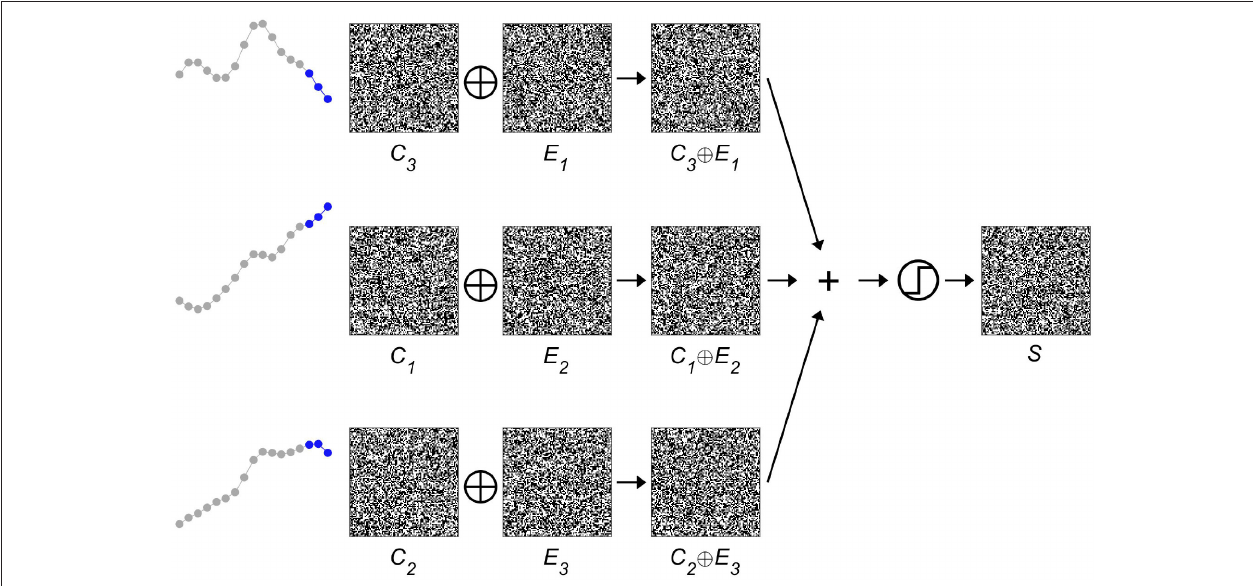
FIGURE 3 | Binding and bundling of hyperdimensional (HD) vectors yield a composite representation S of the spatial intracranial electroencephalogram (iEEG) characteristics. The item memory consists of two groups of HD vectors. One group, C 1 : 4 , represents the four possible order relation patterns, the second group, E 1 : 3 , indicates the three different electrodes. By binding the corresponding pairs of C i ∈ 1 : 4 and E j ∈ 1 : 3 , one arrives at three HD vectors that denote the type and location of the occurring order relation patterns. Bundling, that is superposing and thresholding, these three vectors produces the single composite spatial representation S , which is then further processed as a